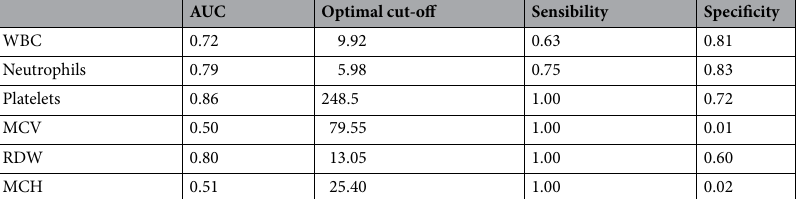
Table 3. Area under de ROC curve and optimal cut-off point . AUC area under the curve, WBC white blood cells, MCV mean corpuscular volume, RDW red cell distribution width, MCH mean corpuscular haemoglobin.